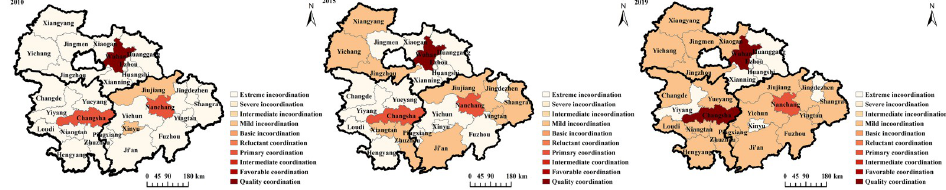
Fig 3. Spatio-temporal evolution of the coupling coordination degree between economic resilience and high- quality economic development in the UAMRYR. The image was created using ArcGIS 10.2 software with the authors’